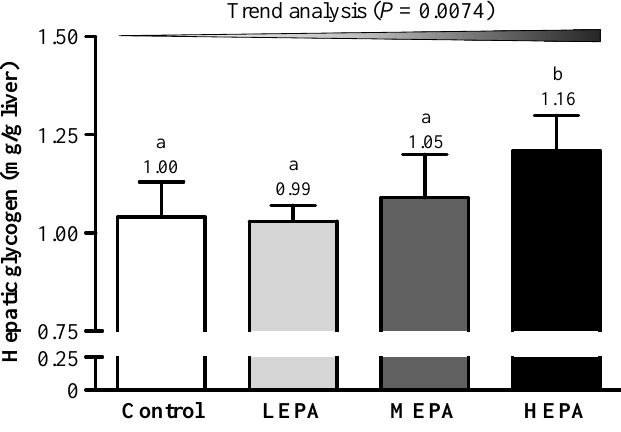
Figure 4. Effect of EPA on hepatic glycogen content in rats. LEPA: low dose (75 mg/kg); MEPA: medium dose (150 mg/kg); HEPA: high dose (375 mg/kg). Data are mean ± SD ( n = 6 rats per group). Different letters (a, b) indicate significant difference at p < 0.05 by the Cochran-Armitage test for dose-effect